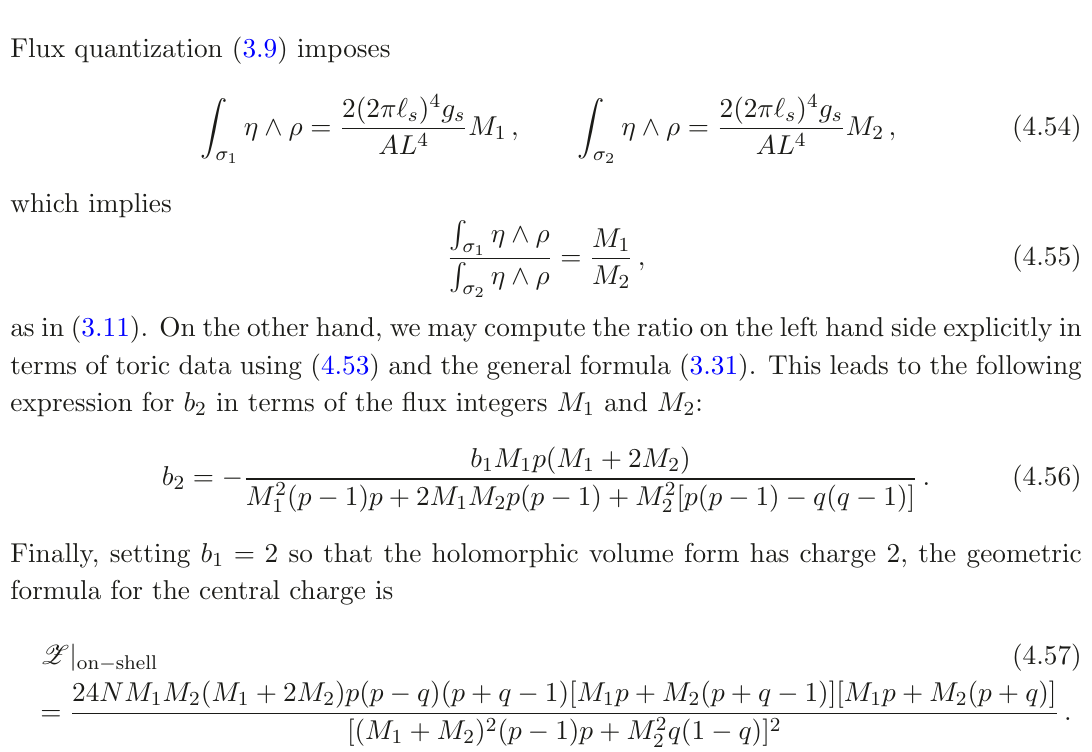
Table 3 . The field content of the X p,q quiver